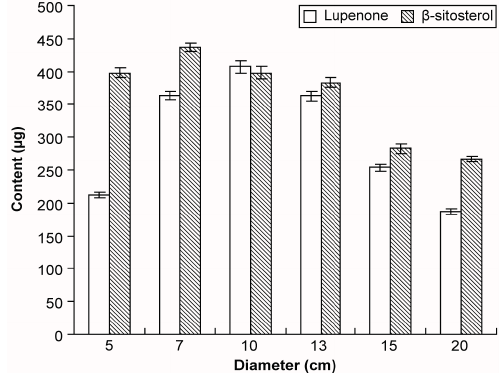
Figure 6. Lupenone and β -sitosterol levels in Rhizoma Musae at different growth stages.